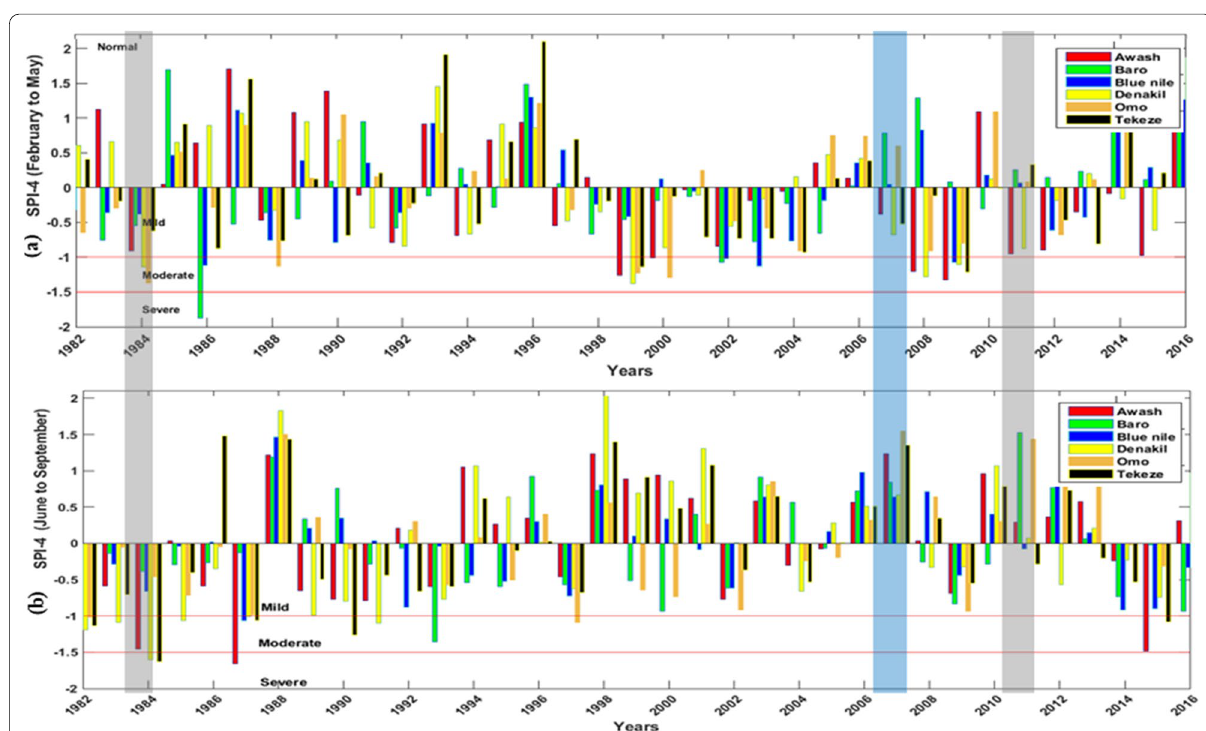
Fig. 8 Time series plot of basin-wide SPI values between 1982 and 2016 during ( a ) smaller rainfall season and ( b ) main rainfall